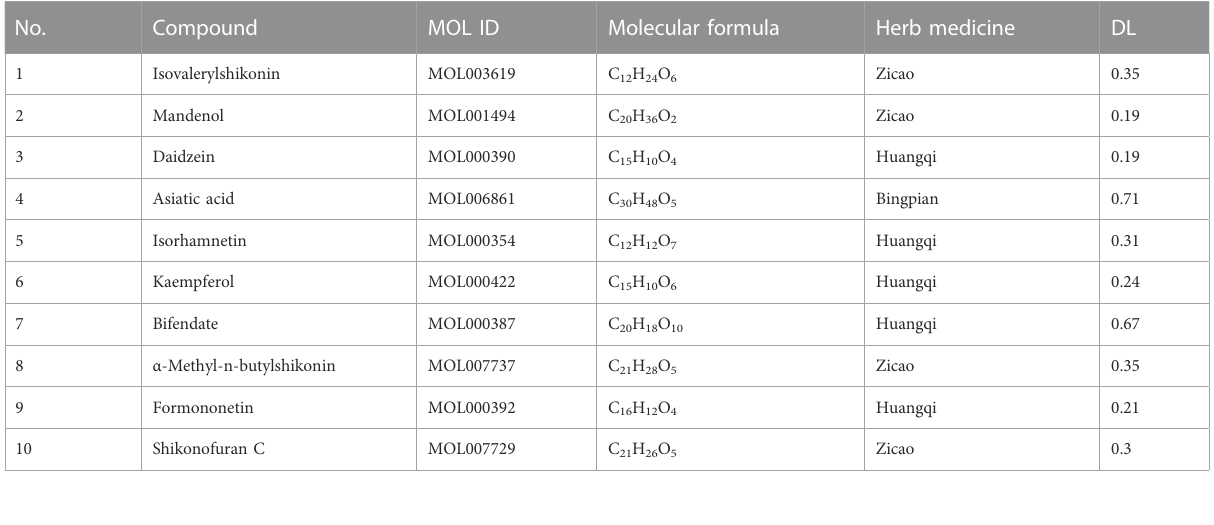
TABLE 3 Information on top 10-degree compounds of ZZO.